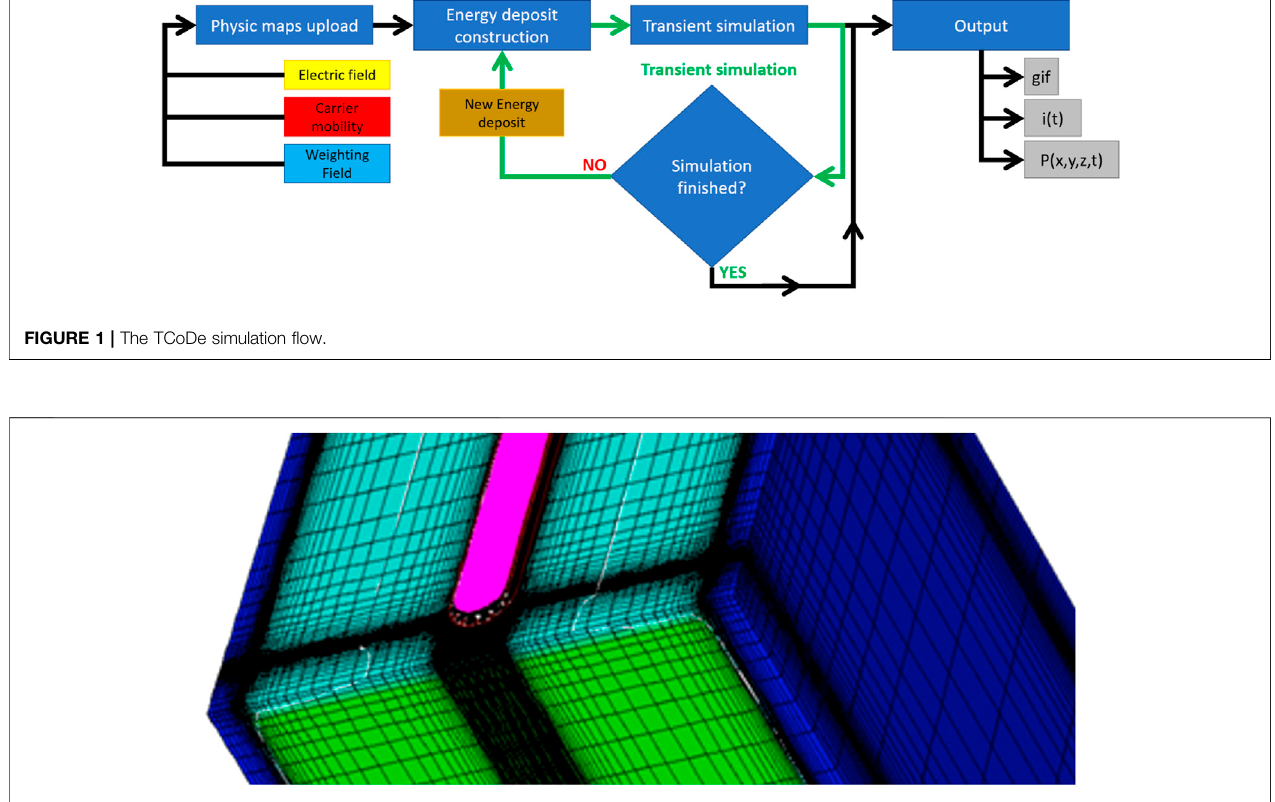
FIGURE 2 | TCAD model of a 3D-silicon sensor with highlighted tensorial mesh